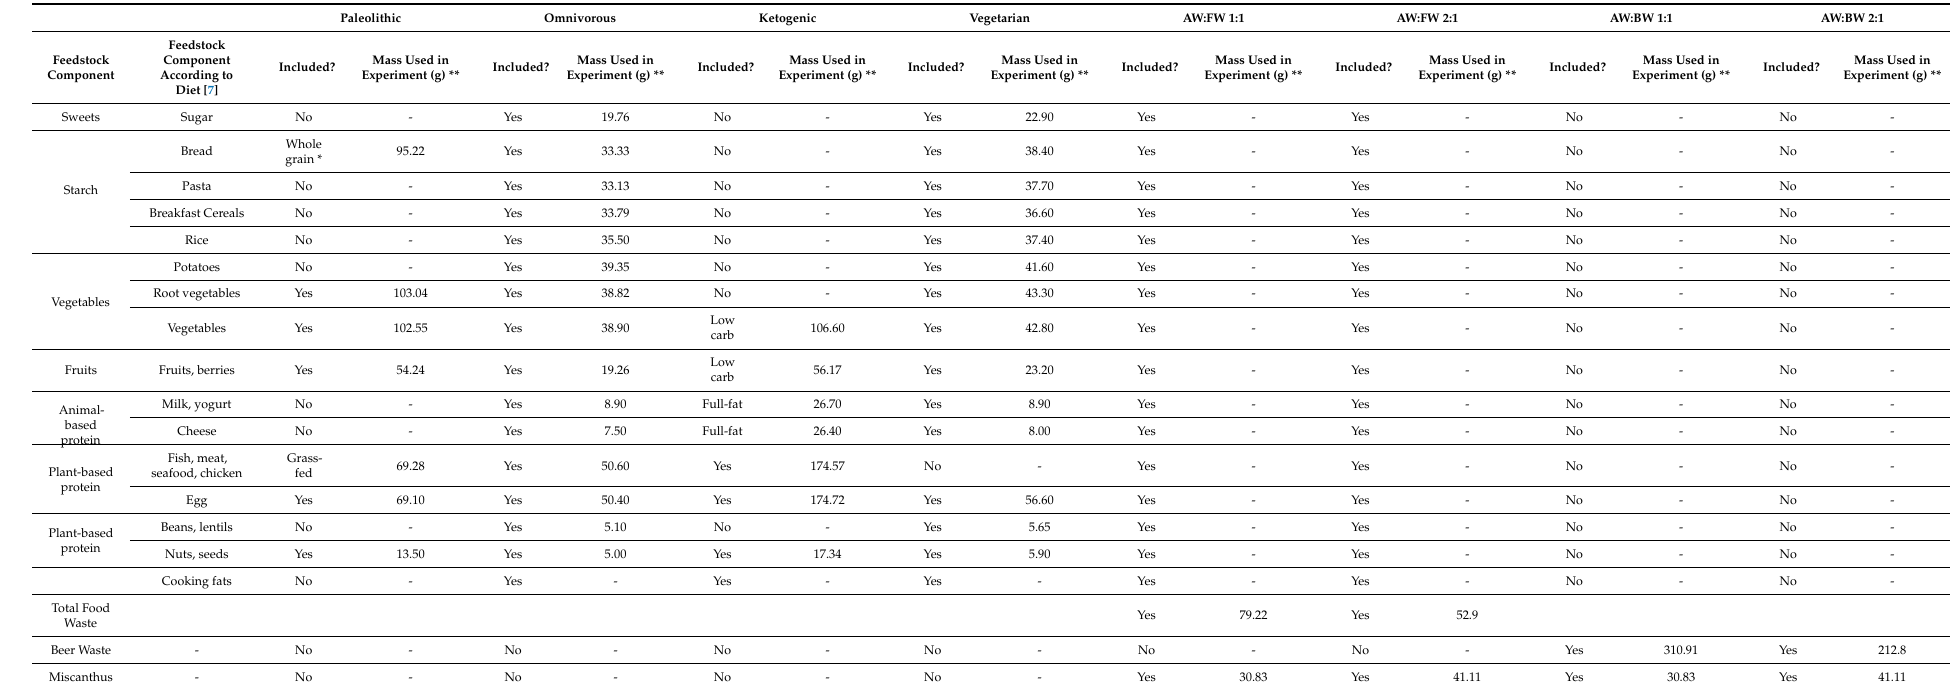
Table 1. Food Waste Treatment